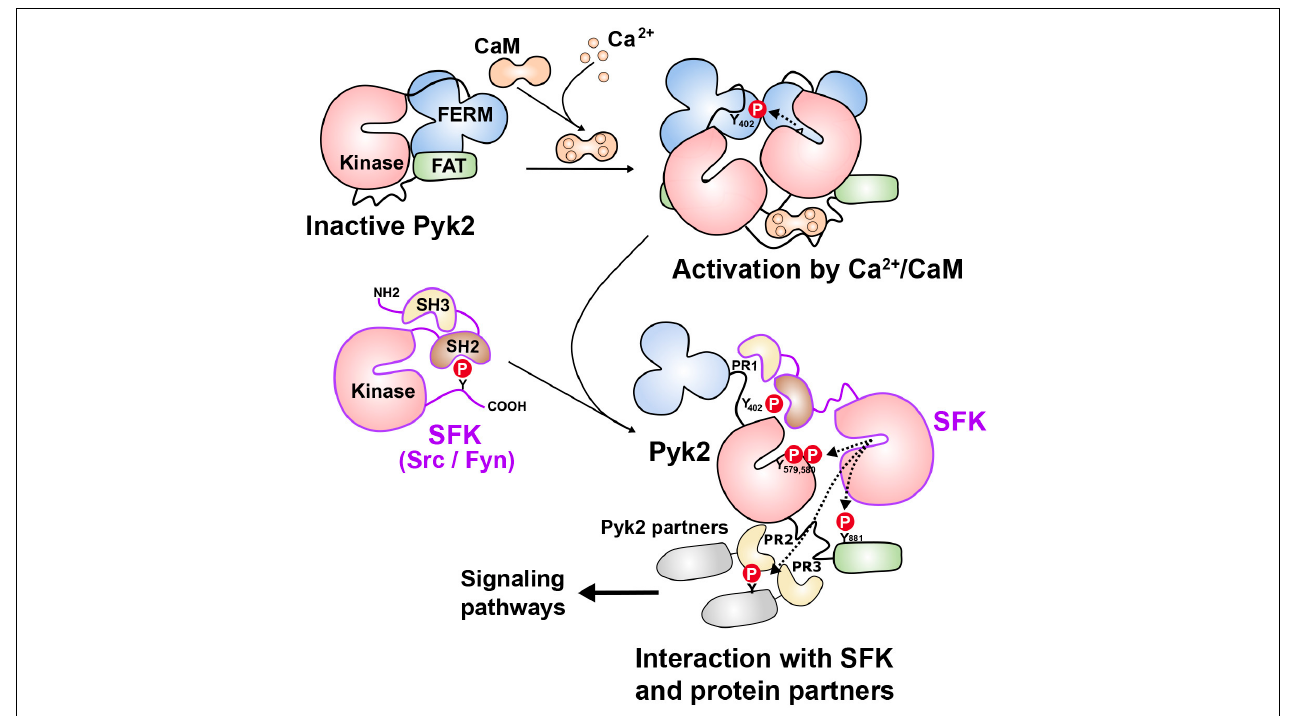
FIGURE 2 | Pyk2 mechanisms of activation. In the absence of stimulus, Pyk2 is thought to be in a closed conformation due to possible intramolecular interactions between domains (top left). Activation can result from the binding of Ca 2 + /calmodulin (Ca 2 + /CaM) for which several potential sites have been identified, including in the FERM domain, the kinase domain, and the kinase-FAT linker (as shown here for simplicity). The binding of Ca 2 + /calmodulin is thought to facilitate dimerization or clustering of Pyk2 allowing intermolecular autophosphorylation of Tyr402 (Y 402 ). Clustering can also result from interaction with partners including PSD-95, which can themselves dimerize or cluster in response to Ca 2 + /calmodulin (not shown). Autophosphorylation of Y 402 provides a binding site for the SH2 domain of Src family kinases (SFKs especially Src and Fyn). Through their SH3 domain, SFKs can also bind to the proline-rich motif (PR1) located close to Y 402 . SFKs can then phosphorylate several tyrosine residues in Pyk2 including Y 579 and Y 580 in its activation loop, increasing its catalytic activity, and Y 881 in the FAT domain, which can recruit additional partners with SH2 domains. SFKs, and possibly Pyk2 can phosphorylate associated proteins, including those interacting with PR2 and PR3 motifs through their SH3 domains. This can result in the formation of multiprotein complexes and the activation of various signaling pathways. Alternatively, activated SFKs can bypass the Ca 2 + /calmodulin-dependent step by directly phosphorylating Y 402 . In either case SFK and Pyk2 interactions provides a positive feedforward activation loop. See text for